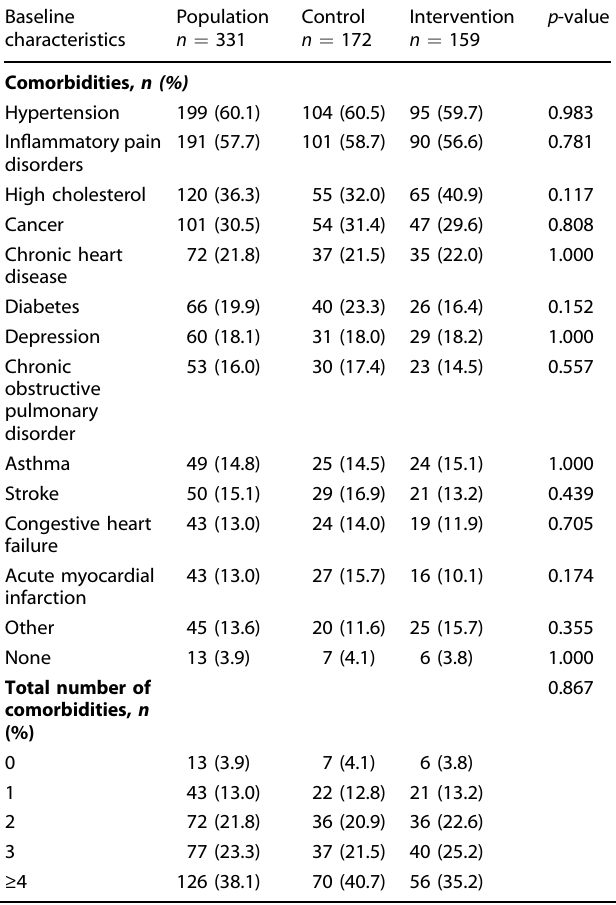
Table 2. Baseline characteristics by group — comorbidities. Table 3. Patients in the IG receiving each step of the Stepped-Care approach and types of tailored